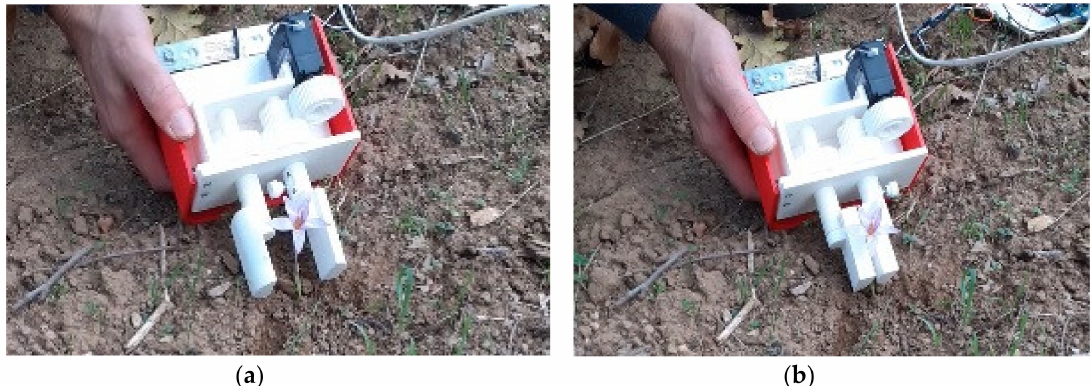
Figure 20. Field tests on wild saffron flowers: ( a ) approaching the flower; ( b ) harvesting